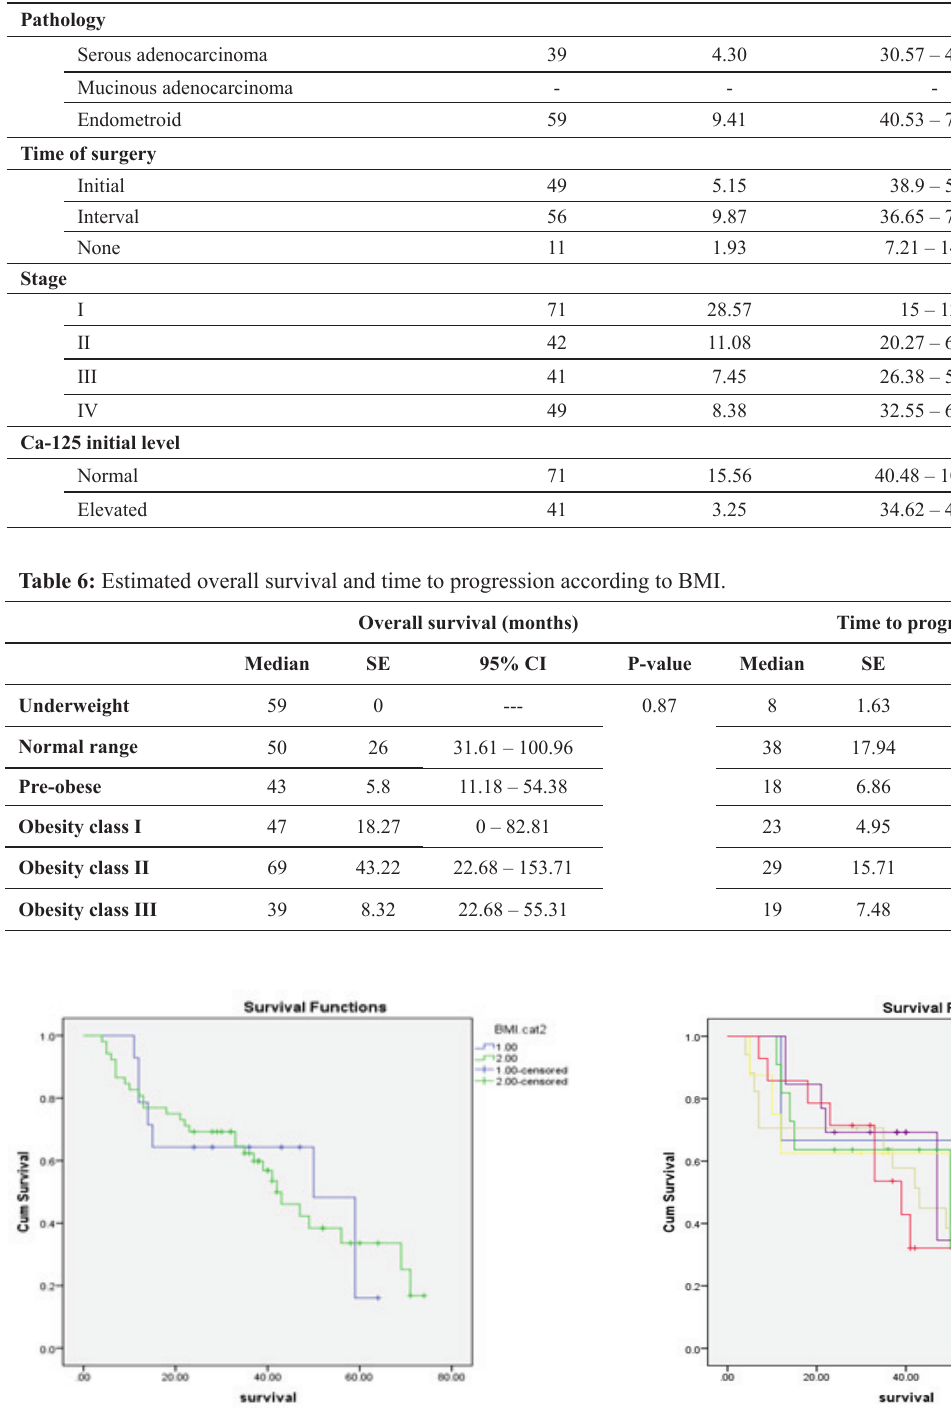
Figure. 1: Kaplan Meier curves showing overall survival of patients with BMI ≤25 and those with BMI >25